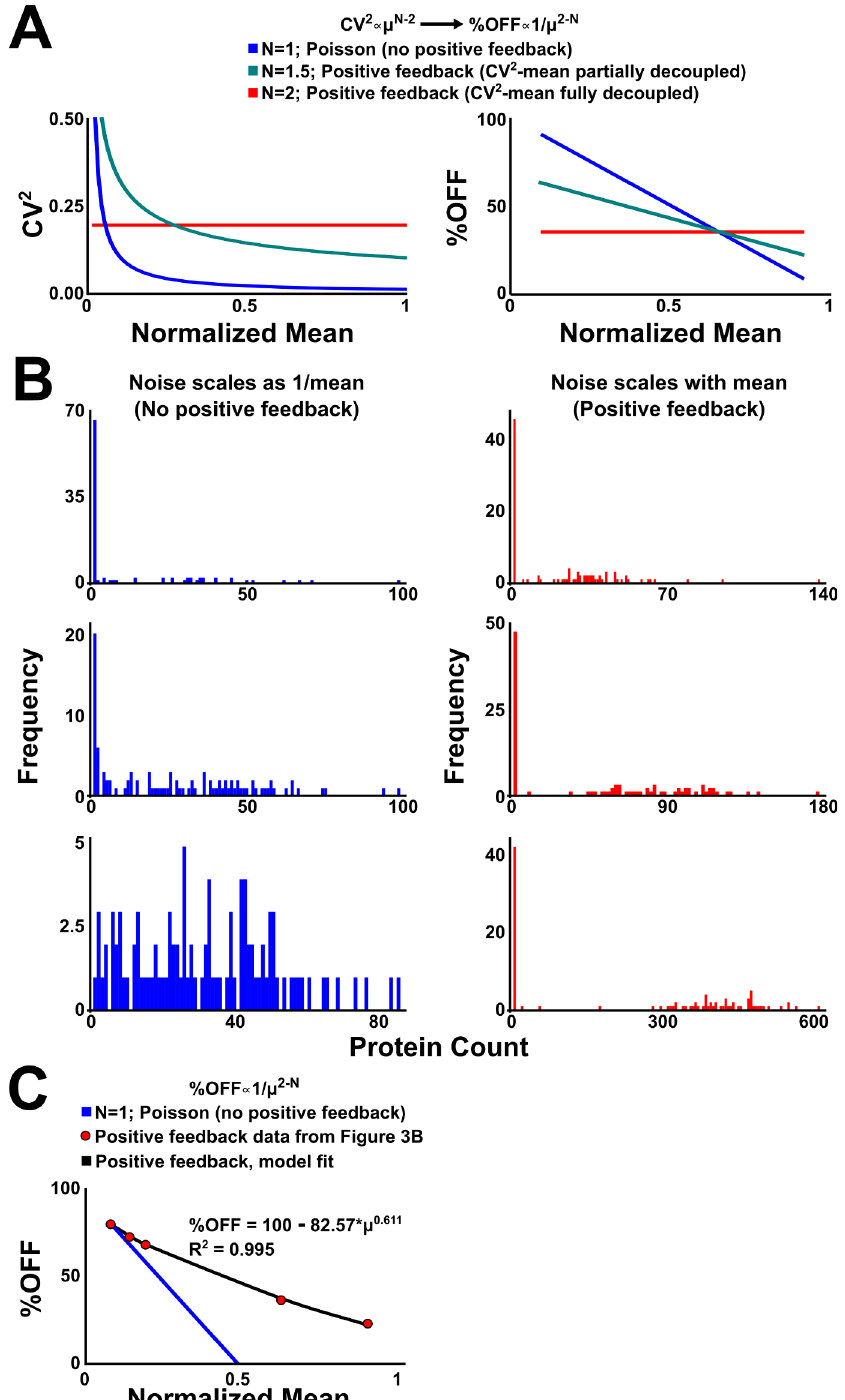
Fig 5. Nonlatching positive feedback substantially dampens the Poissonian noise-mean inverse relationship, allowing stochastic extinction despite increasing mean-expression levels. (A) In the classical Poisson or super-Poissonian transcriptional burst models [50], the expressionmean scales with variance( σ 2 / μ ) such that the noise magnitude (CV 2 = σ 2 / μ 2 ) decreases proportionally to the inverseof the mean. Nonlatchingpositive feedbackbreaks the Poissonian relationshipsuch that σ 2 / μ N with 1 < N < 2 [44]. In the extreme case where N = 2, CV 2 becomes independent of the mean. (B) Monte-Carlo (Gillespie) simulations for three different populationmean values in absence(left) and presence(right) of positive feedbackshowingthat stochastic extinction can be decoupled from the mean (when N = 2). (C) Analysis of the data in Fig 3 shows that the Tat circuit displayspartial decouplingof noise and mean ( N (cid:25) 1.5).